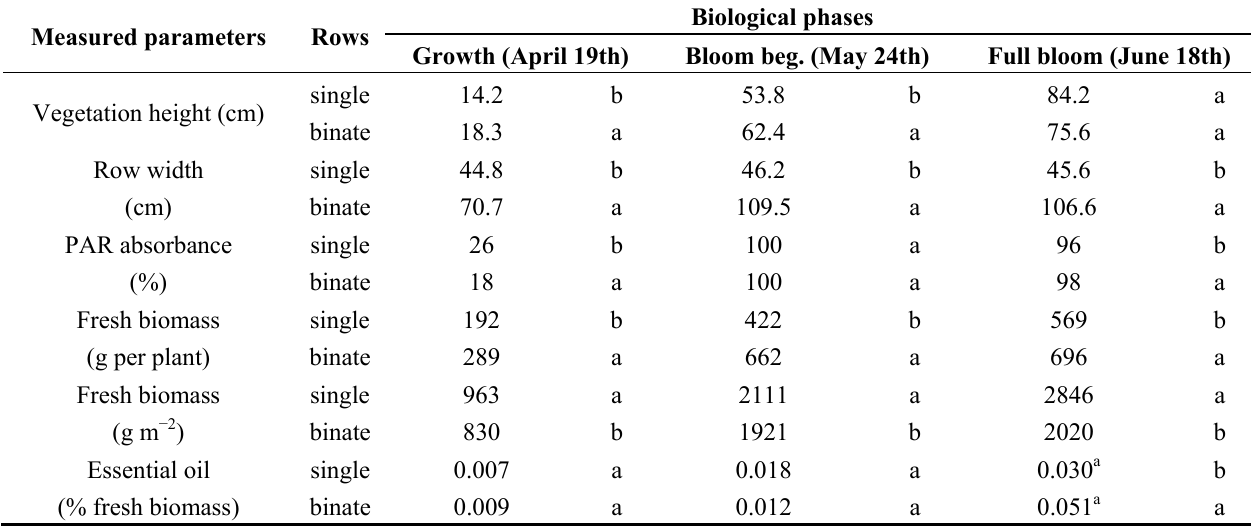
Table 1. Results related to the parameters measured during the growth of oregano in the field